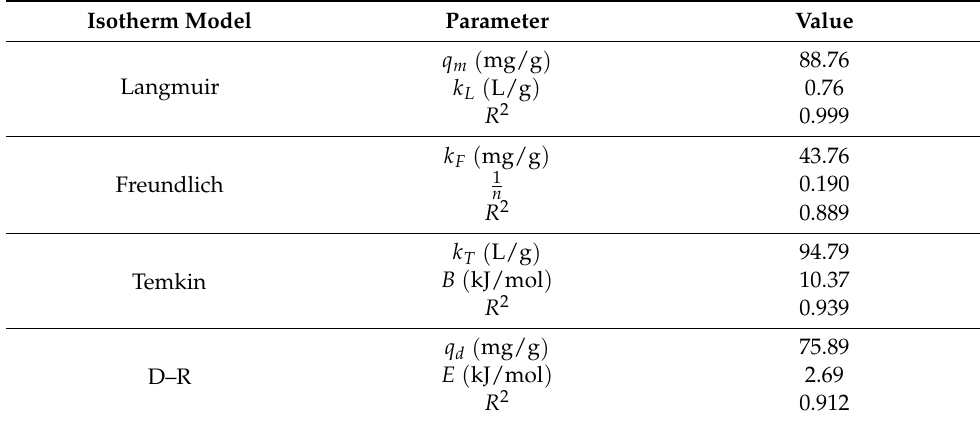
Figure 6. Langmuir ( a ), Freundlich ( b ), Temkin ( c ), and D–R ( d ) isotherm models for Pb 2+ sorption by the developed modified ZnO NP/DPF solid extractor. Table 3. Isotherm models and their parameters for Pb 2+ sorption from model aqueous solutions onto the modified ZnO NP/DPF